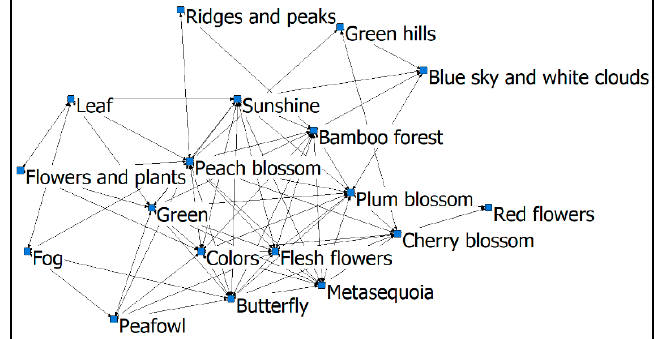
Figure 11. 3-1. Natural scenery based on visual and tactile interactive perception.